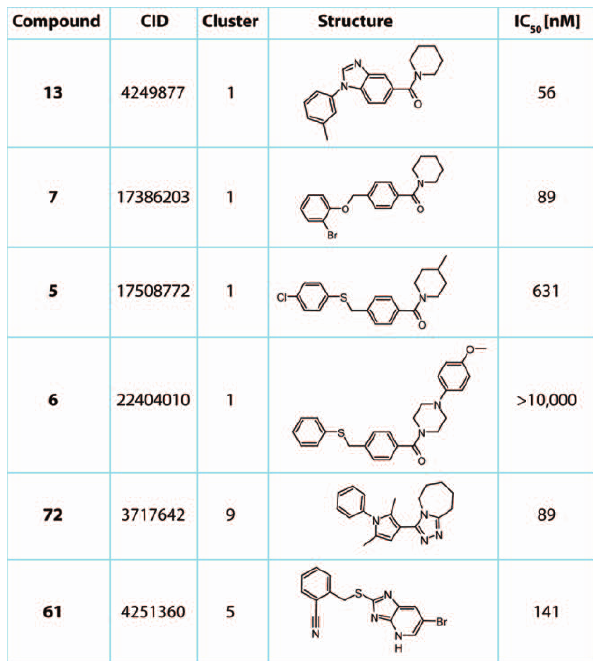
Figure 2. IC 50 from re-testing for selected inhibitors of human 15-PGDH identified in the quantitative high-throughput screen. Shown are the IC 50 values for select compounds arranged by cluster number, along with their PubChem Chemical Identifiers (CID). doi:10.1371/journal.pone.0013719.g002 compared to 56 nM calculated according to the re-test results, and for compounds 61 and 72 , respectively, values of IC 50 of 26.4 6 2.4 and 15.0 6 1.2 nM were determined (compared to 141 nM and 82 nM, respectively). All three compounds caused a maximum of 100% inhibition (Figure 4B).